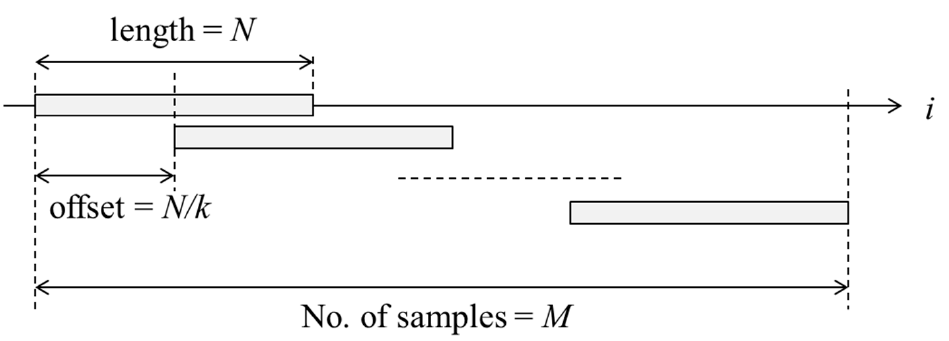
Figure 13. Scheme of RMS signal recovery.